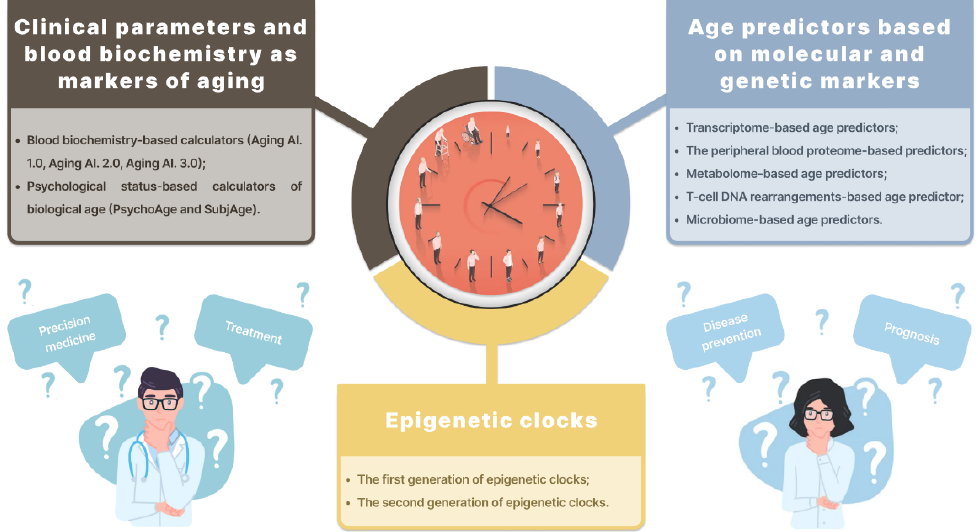
Figure 1. Biological age predictors mentioned in this review.